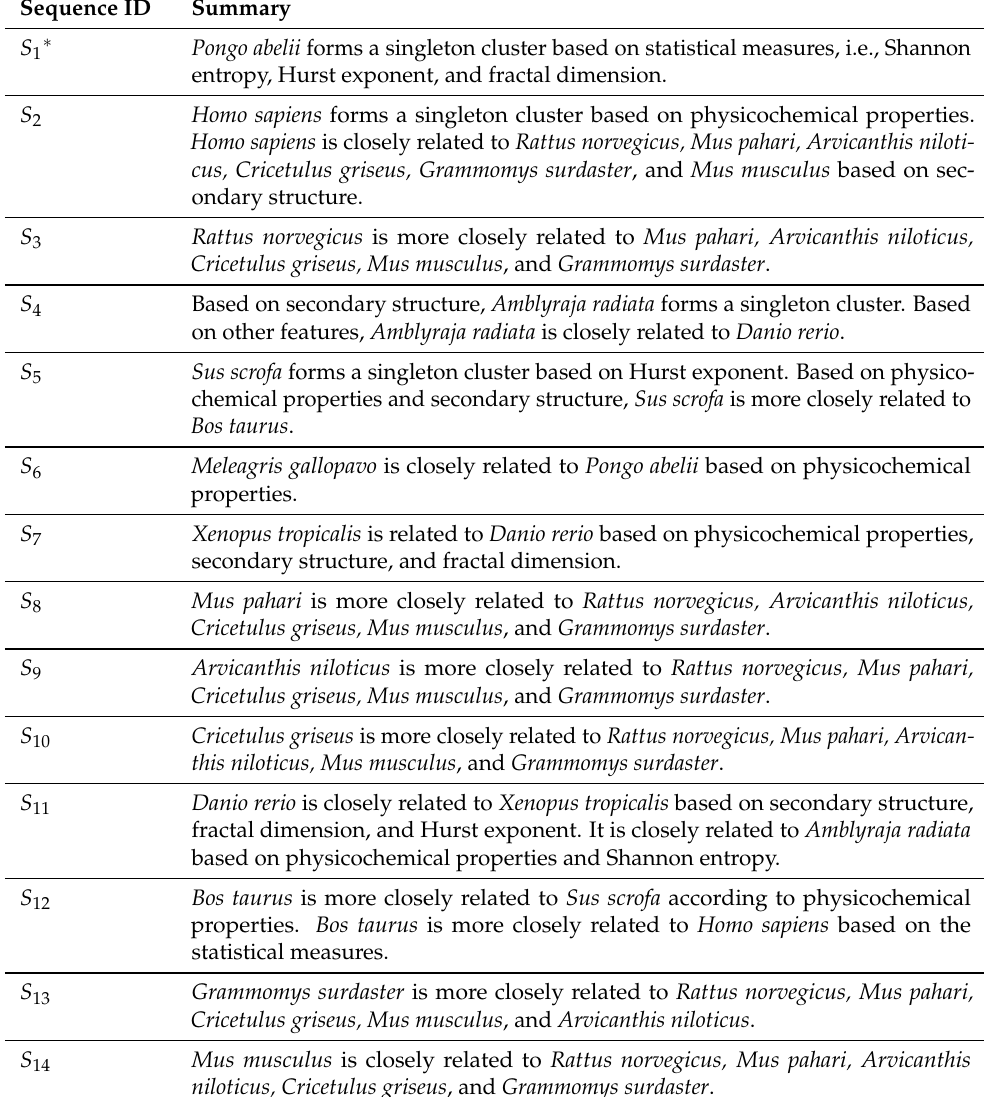
Table 2. Comprehensive analysis of ALDH2 sequences of fourteen